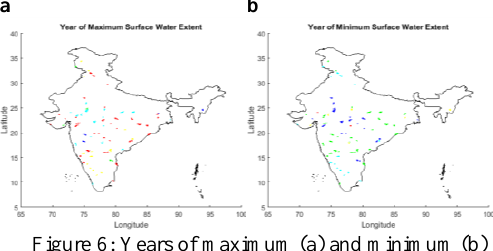
Figure 6: Years of maximum (a) and minimum (b) surface water extent of each wetland. Denotations are Red: 2013-14; Yellow: 2014-15; Green: 2015-16; Cyan: 2016-17 and Blue: 2017-18.